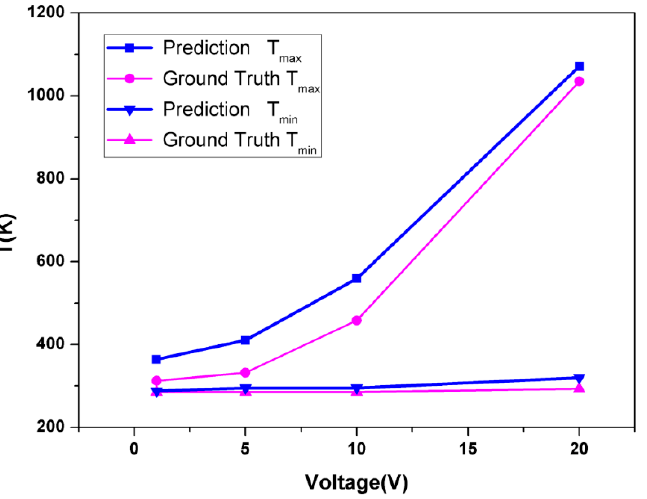
Figure 6. Comparison of predicted and calculated values of maximum and minimum temperatures at different voltages.